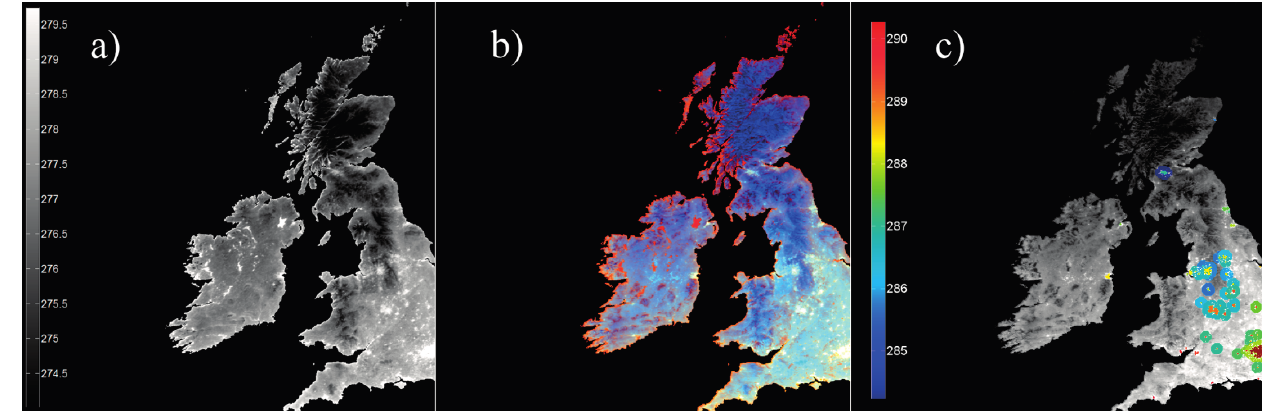
Figure 7. Results of the surface urban heat island analysis for Great Britain. ( a ) Nighttime MAST; ( b ) Composite of nighttime MAST, daytime MAST, and ∆ MAST day-night ; ( c ) Daytime surface urban heat island of metropolitan areas. Mean MAST of urban and surrounding non-urban